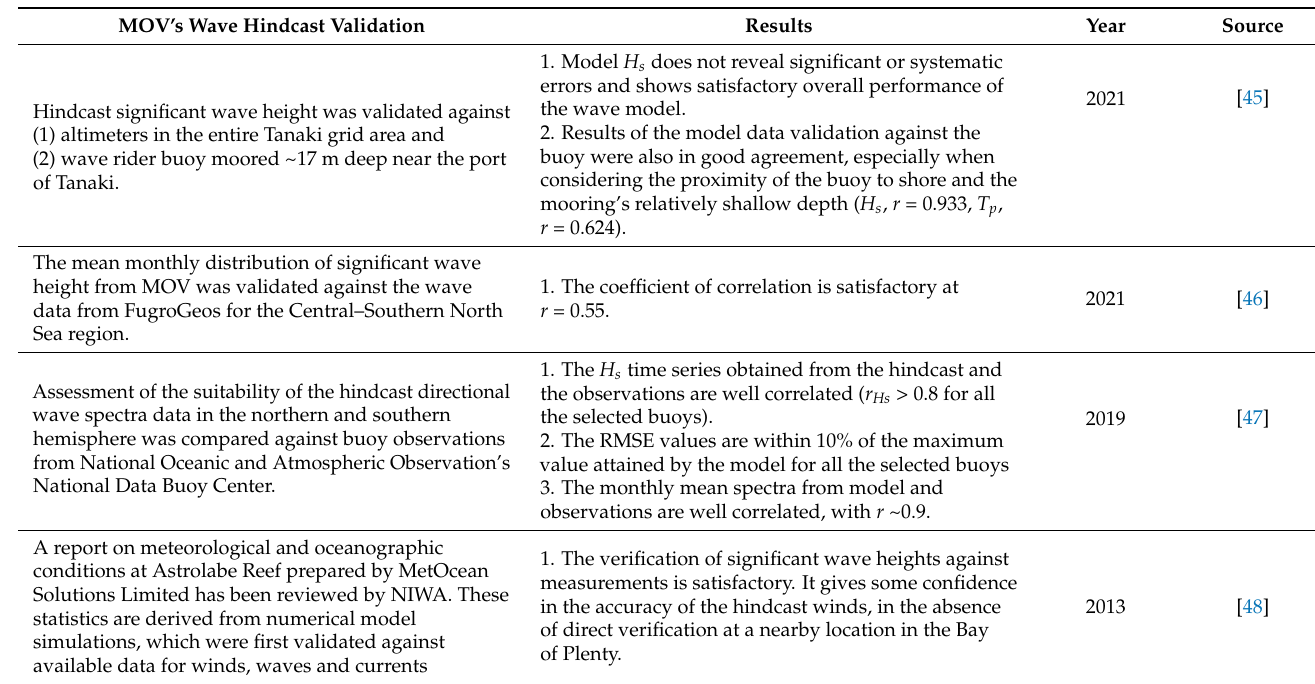
H s and P d were computed using the hindcast data from MOV. Table 3. Studies conducted that validate MOV’s